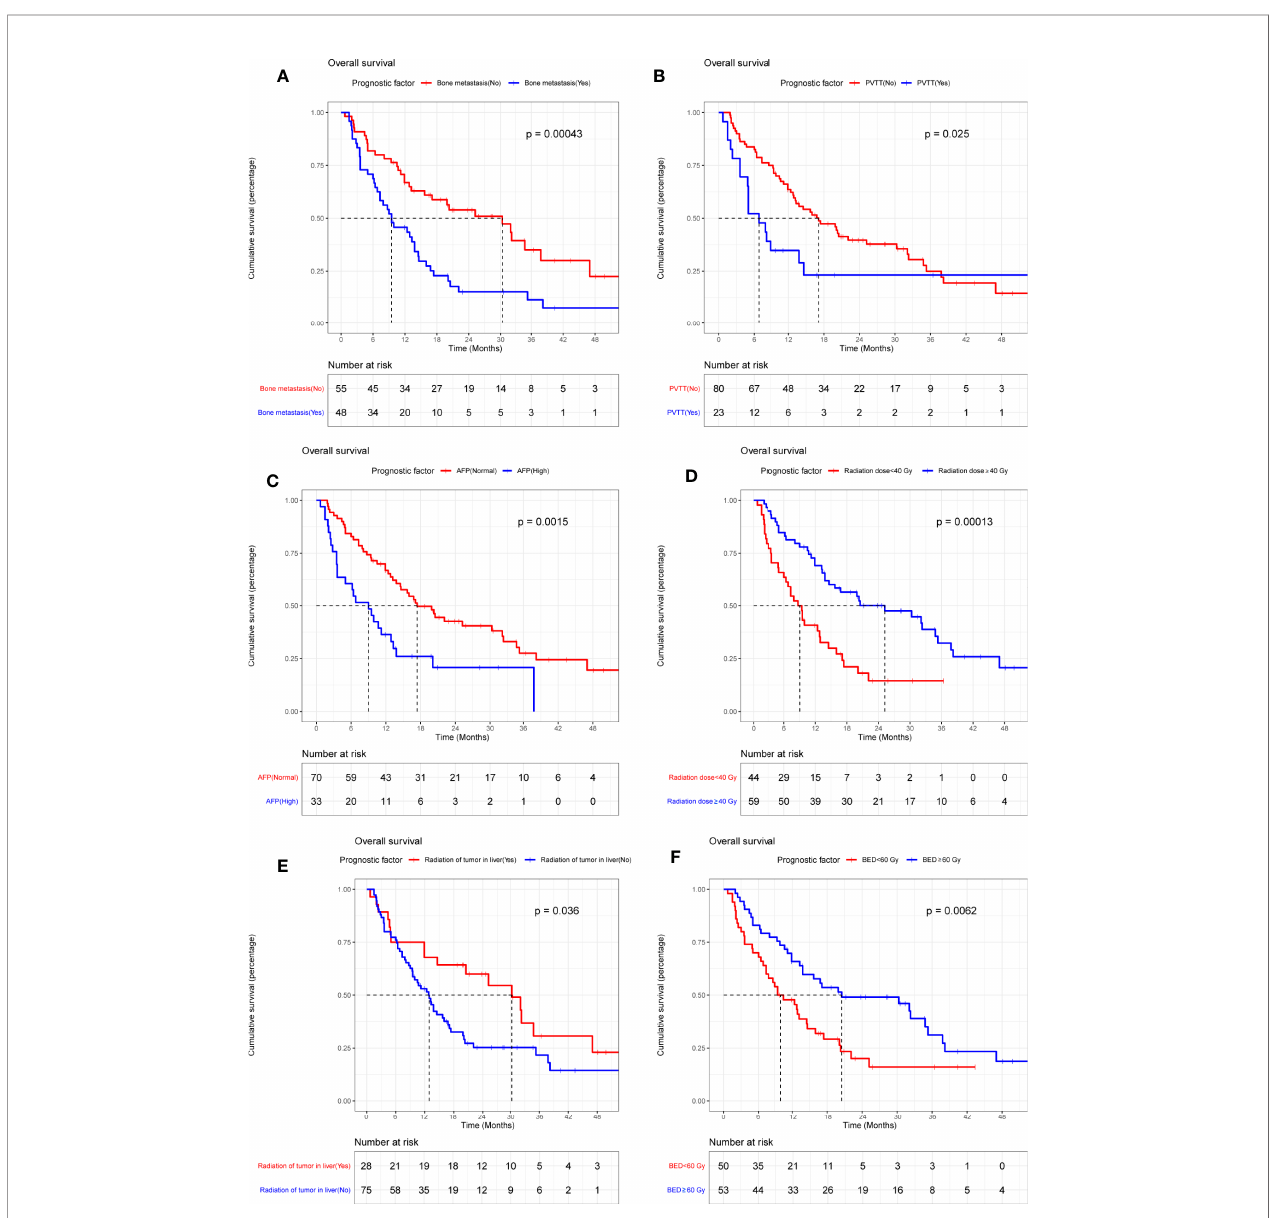
FIGURE 2 | Kaplan-Meier plots of overall survival strati fi ed by bone metastasis (A) , portal vein tumor thrombus (B) , alpha-fetoprotein (C) , radiation dose (D) , radiation of tumor in liver (E) , and BED (F)